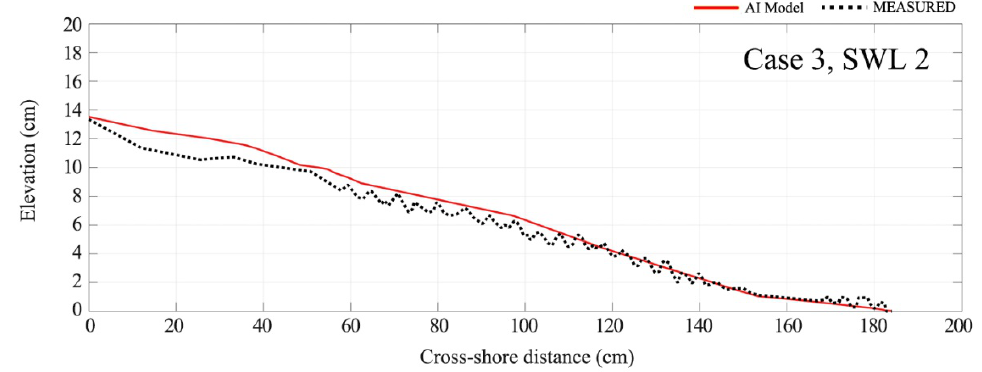
15 of 19 Figure 16. Case 2 SWL 1 comparison of the ANN prediction and measured from the physical test. Figure 17. Case 2 SWL 2 comparison of the ANN prediction and measured from the physical test. In test case 3 with SWL 1, shown in Figure 18, the ANN model predicted less erosion on the backshore compared to the measured profile evolution. Although the overall ten- dency of the beach profile to reach equilibrium was predicted, the amount of erosion was not accurately predicted. Nonetheless, the prediction of the ANN for test case 3 with SWL 2 in Figure 19 was more accurate than the case 3 with SWL 1 prediction. Erosion was accurately predicted for the berm and foreshore.